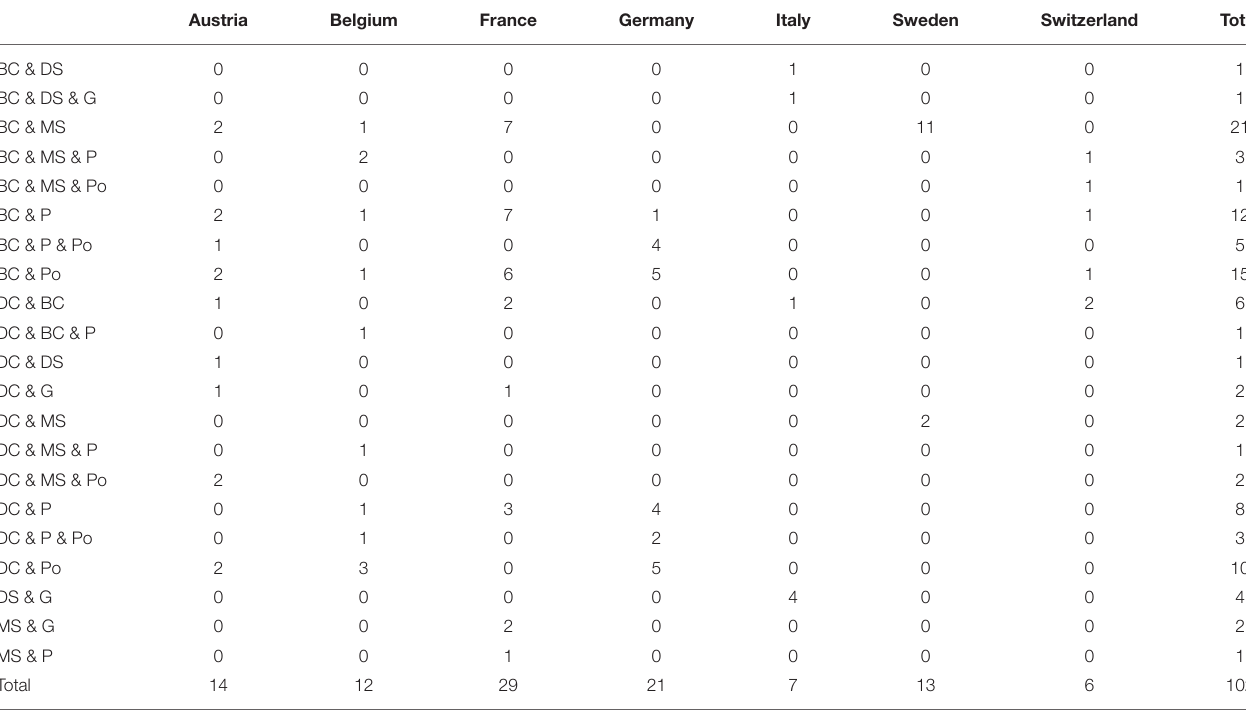
TABLE 1 | Livestock combinations surveyed per